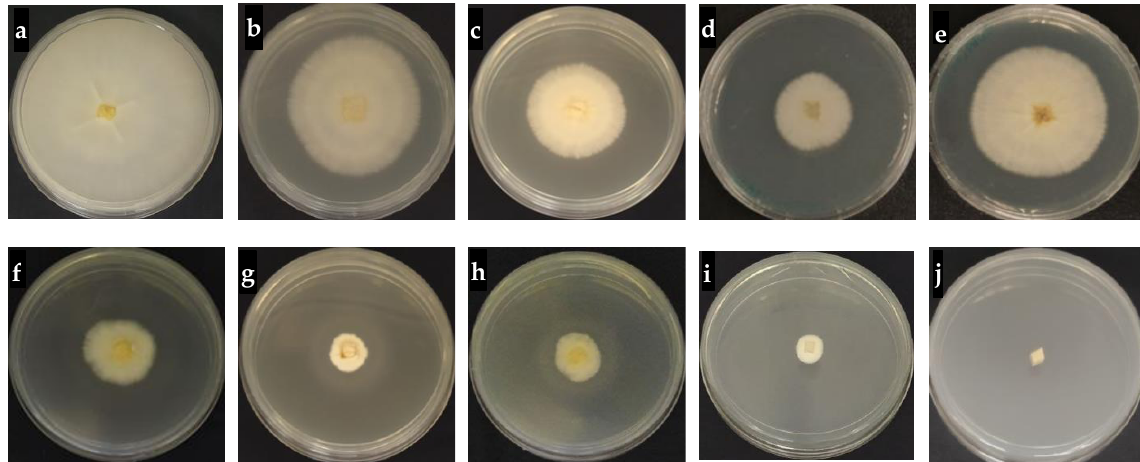
Figure 9. The inhibition zone of Ganoderma boninense incubated with 50 ppb of the sample after 7 days; control ( a ) HMBS-1 ( b ), HMBS-2 ( c ), HMBS-4 ( d ), HMDS-1 ( e ), HMDS-2 ( f ), HMDS-4 ( g ) and HMT-6 ( h ), HMT-8 ( i ) and HMT-10 ( j ).